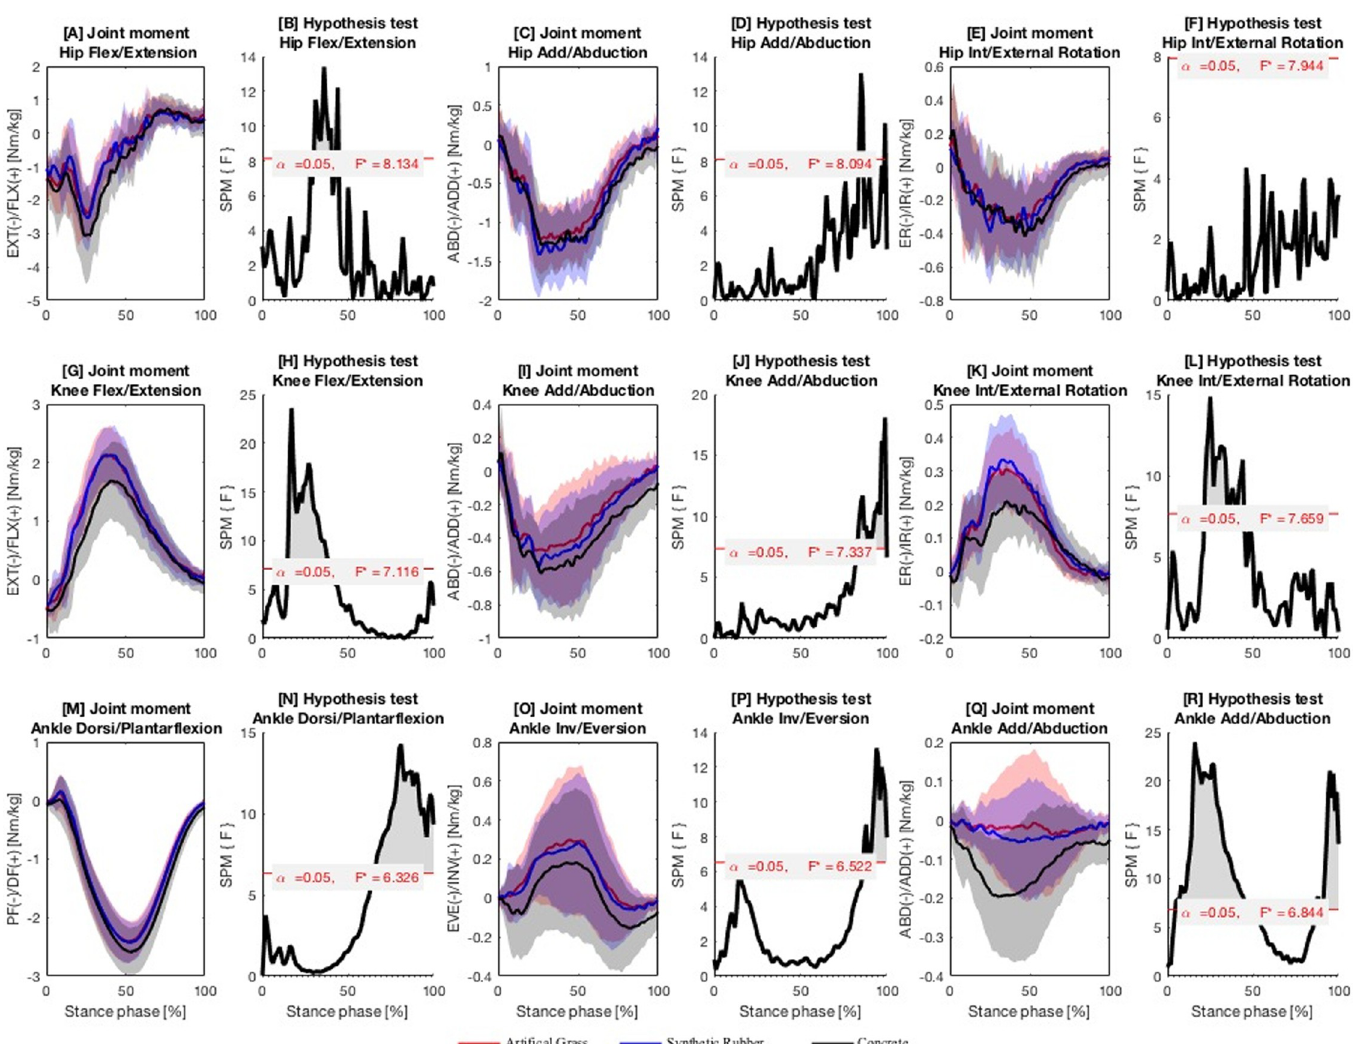
Fig 3. Lower extremity joint moments. Ensemble time series of 3D joint moments and the corresponding results of statistical parametric mapping analysis (hip joint moment: A–F; knee joint moment: G–L; ankle joint moment: M–R) across participants during running on artificial grass, synthetic rubber and concrete surfaces. Areas of significant differences are marked in shaded grey. F � = critical